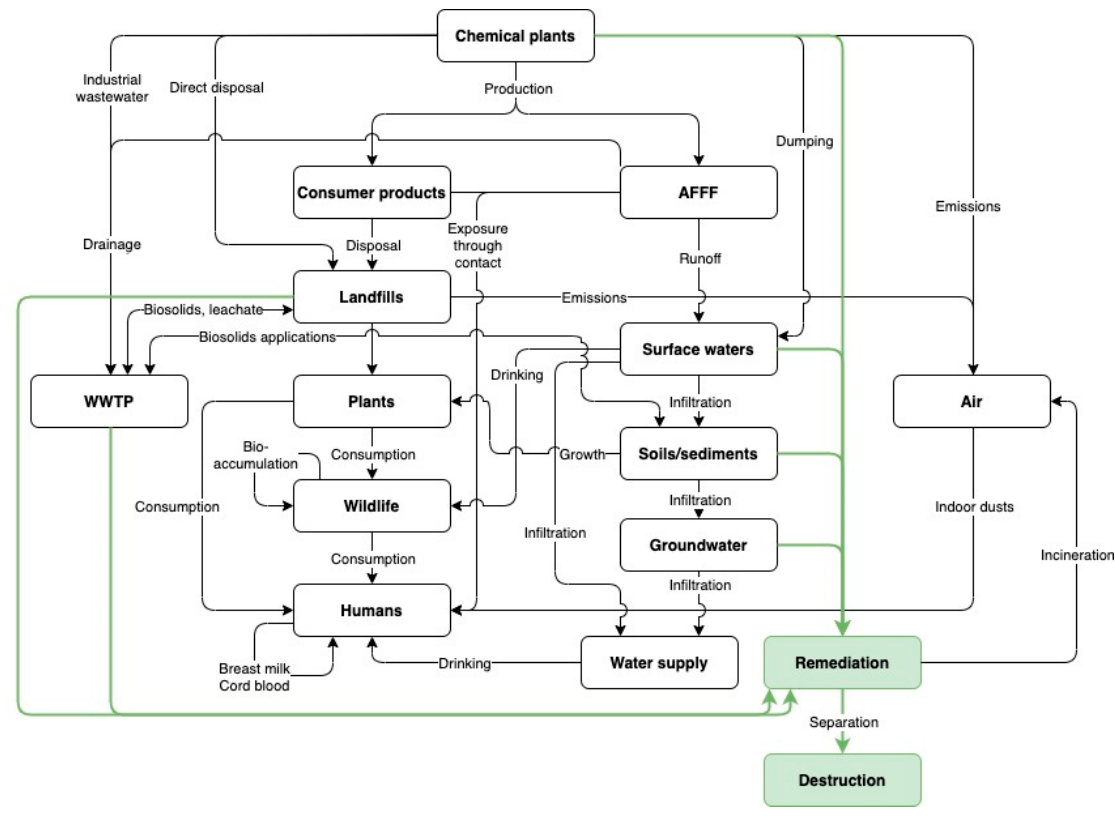
Figure 3. Pathways of PFAS environmental release and exposure [6,10,77–94].